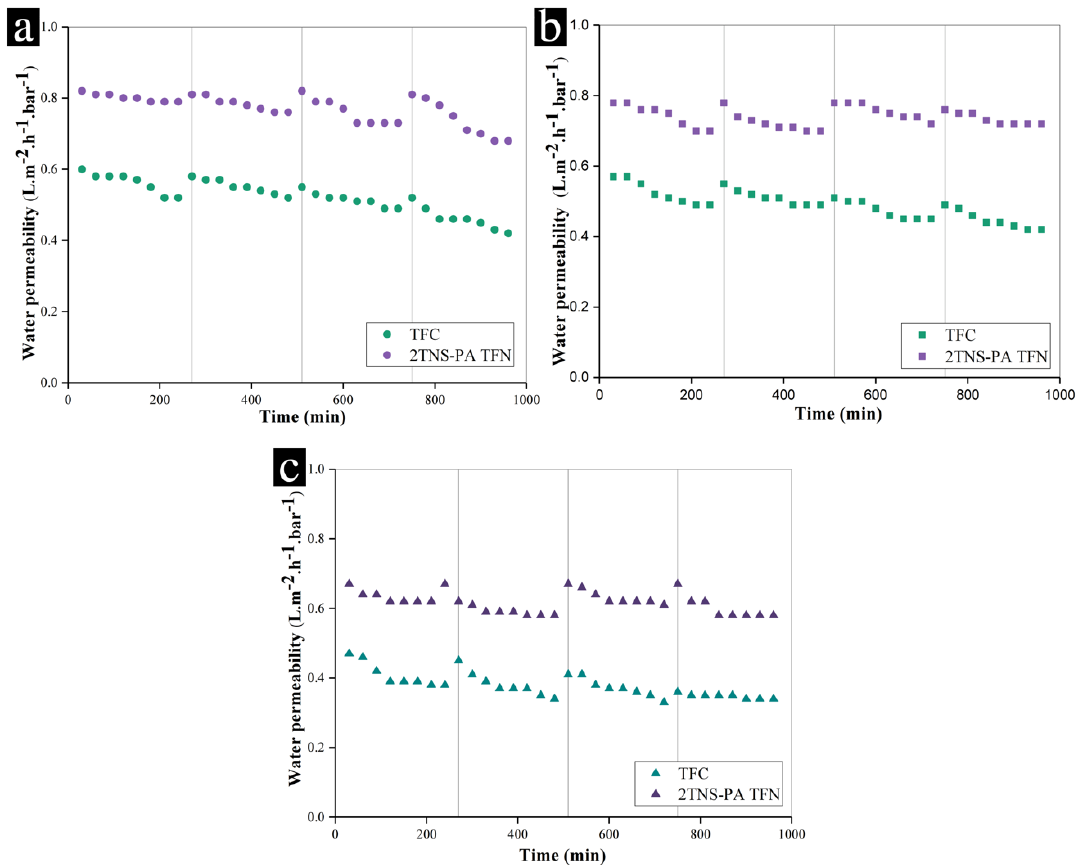
Figure 4. Comparison of water permeability for TFC and 2TNS-PA TFN membranes at high different oily saline feedwater of ( a ) 1000 ppm oily saline water, ( b ) 5000 ppm oily saline water and ( c ) 10,000 ppm oily saline water (grey lines represent the water recovery after washing).